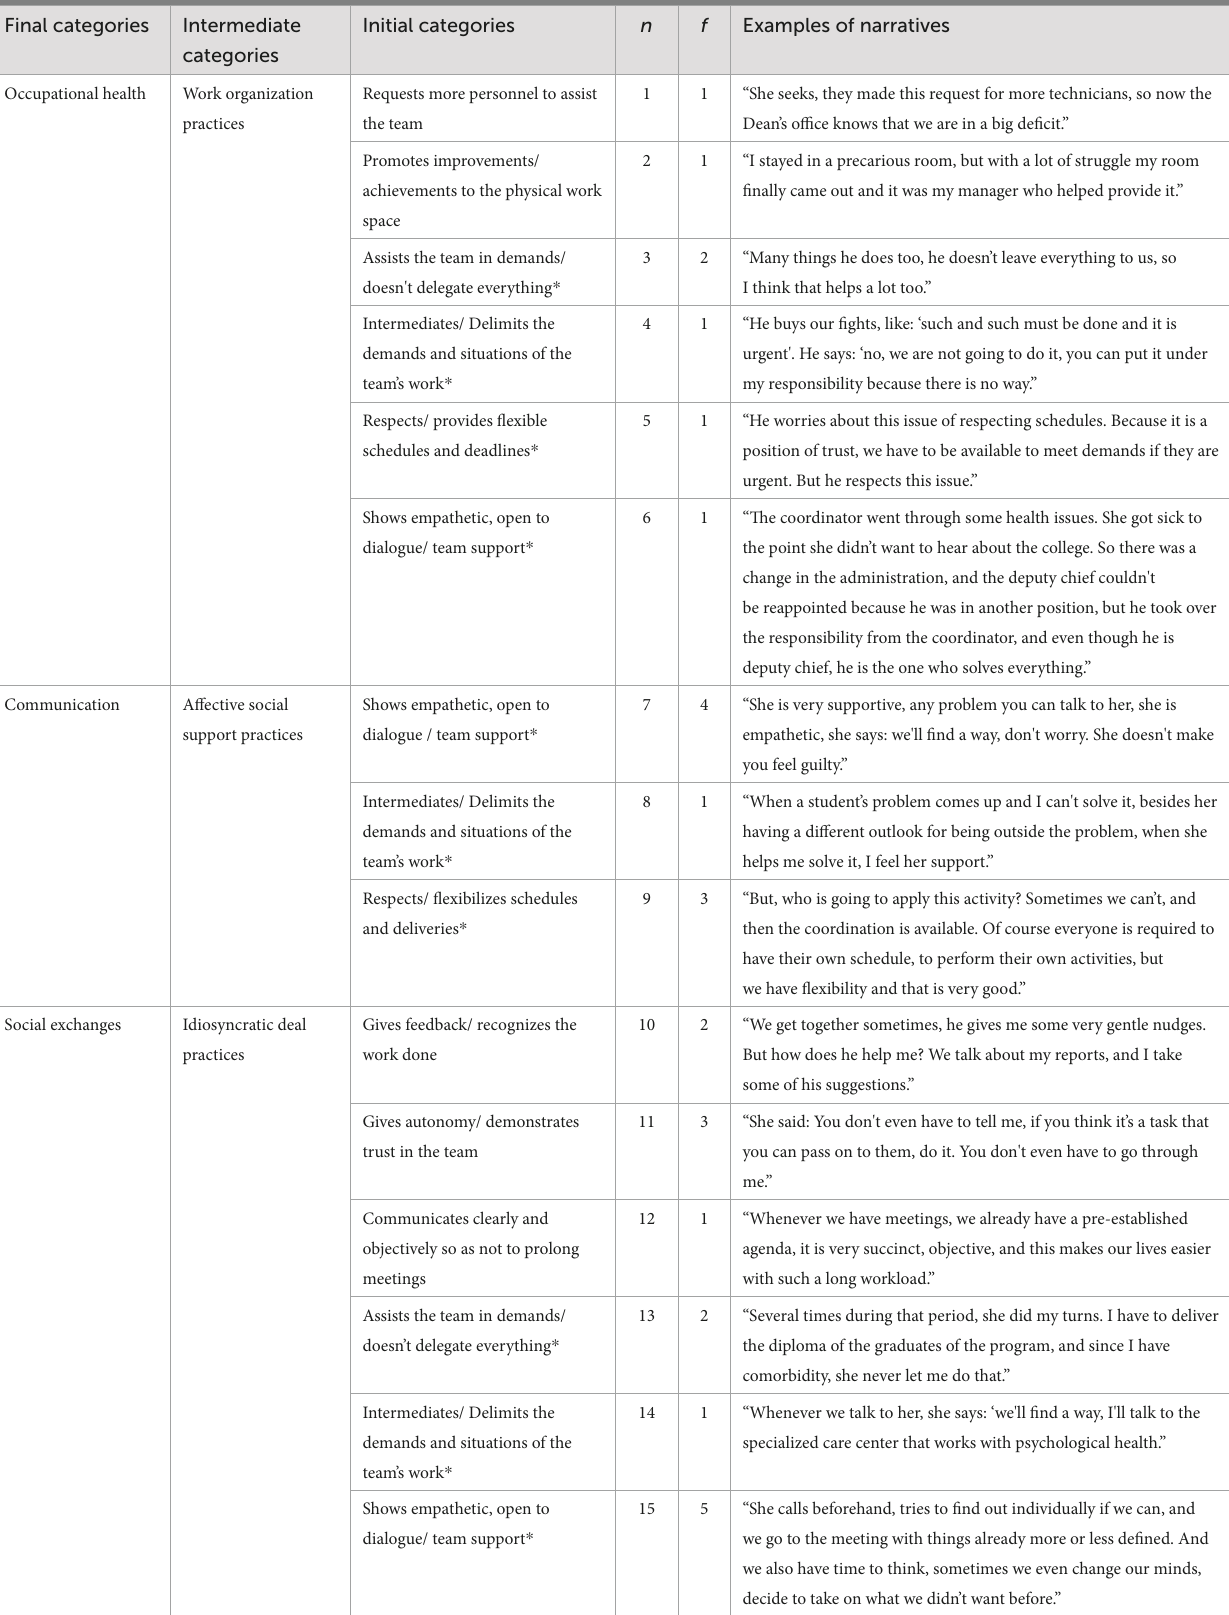
TABLE 2 Human resource management practices adopted according to the teams’ perception. Human resource management practices adopted according to the teams’